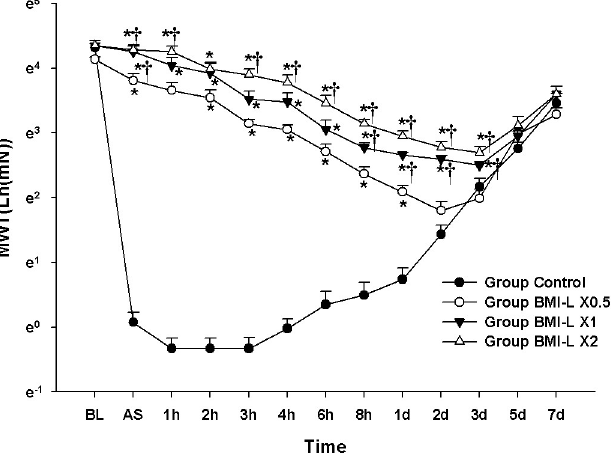
Fig 3. Evaluation of analgesic effect according to dose of BMI component: BMI component dose response test. The graphs are presented as means ( ± standard error of the mean) of the log-transformed mechanical withdrawal threshold with von Frey filaments. Mechanical withdrawal threshold with von Frey filaments. BL: baseline, AS: after surgery. � P < 0.05 compared with Group Control, † P < 0.05 compared with Group Fixed Lidocaine + BMI X 0.5.